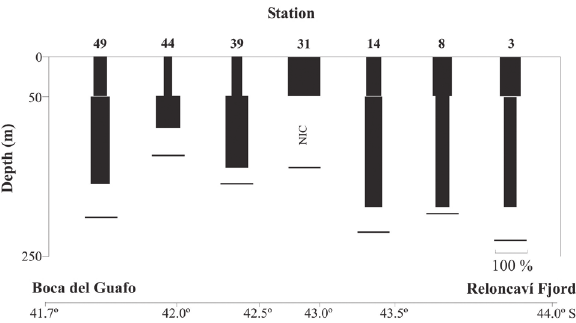
Fig . 5. – Vertical distribution in percentage of Sagitta tasmanica . Black bars indicate the depth of the marine floor at the sampling stations. NIC: no individuals were collected.